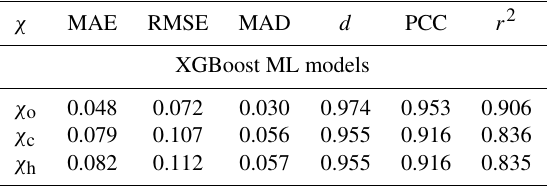
Table 2. Predictive performance of the ML models using the test- ing data set. Metrics include the mean absolute error (MAE), root- mean-square error (RMSE), median absolute deviation (MAD), in- dex of agreement ( d ; Willmott, 1981), Pearson correlation coeffi- cient (PCC), and coefficient of determination ( r 2